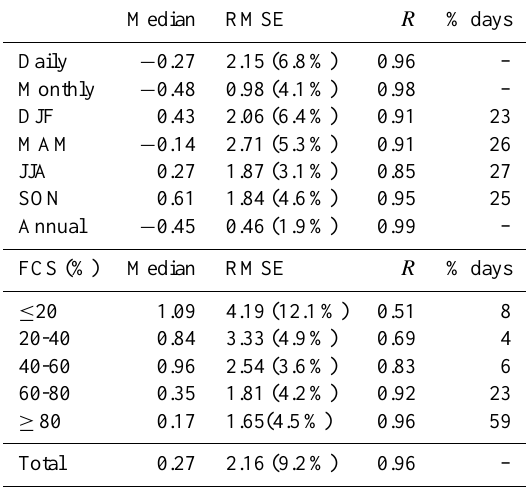
Figure 4. Box plot of the (a) annual cycle of the bias (MJm − 2 ) Fig. 4. Box plot of the (a) annual cycle of the bias (MJm (cid:0) 2 ) and (b) and (b) bias versus fraction of clear sky values (FCS) from 1997 to